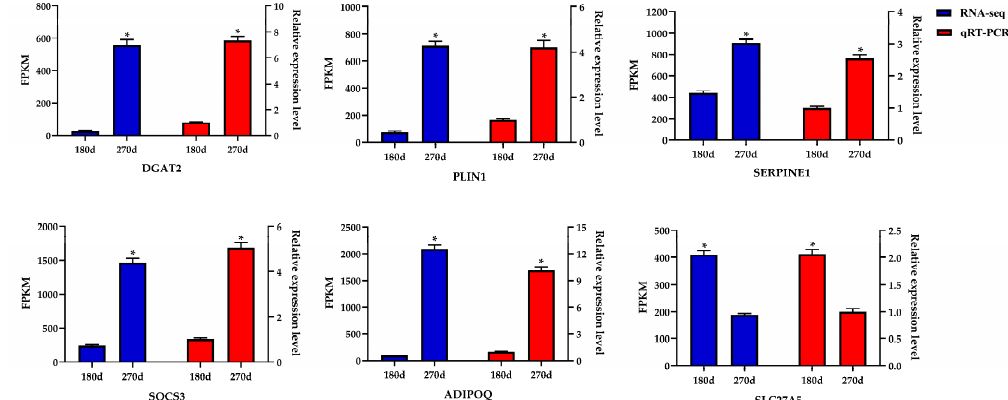
Figure 2. Expression level of six DEGs detected by RNA-Seq and qRT-PCR. Values are presented as the mean ± standard errors; *, p < 0.05.